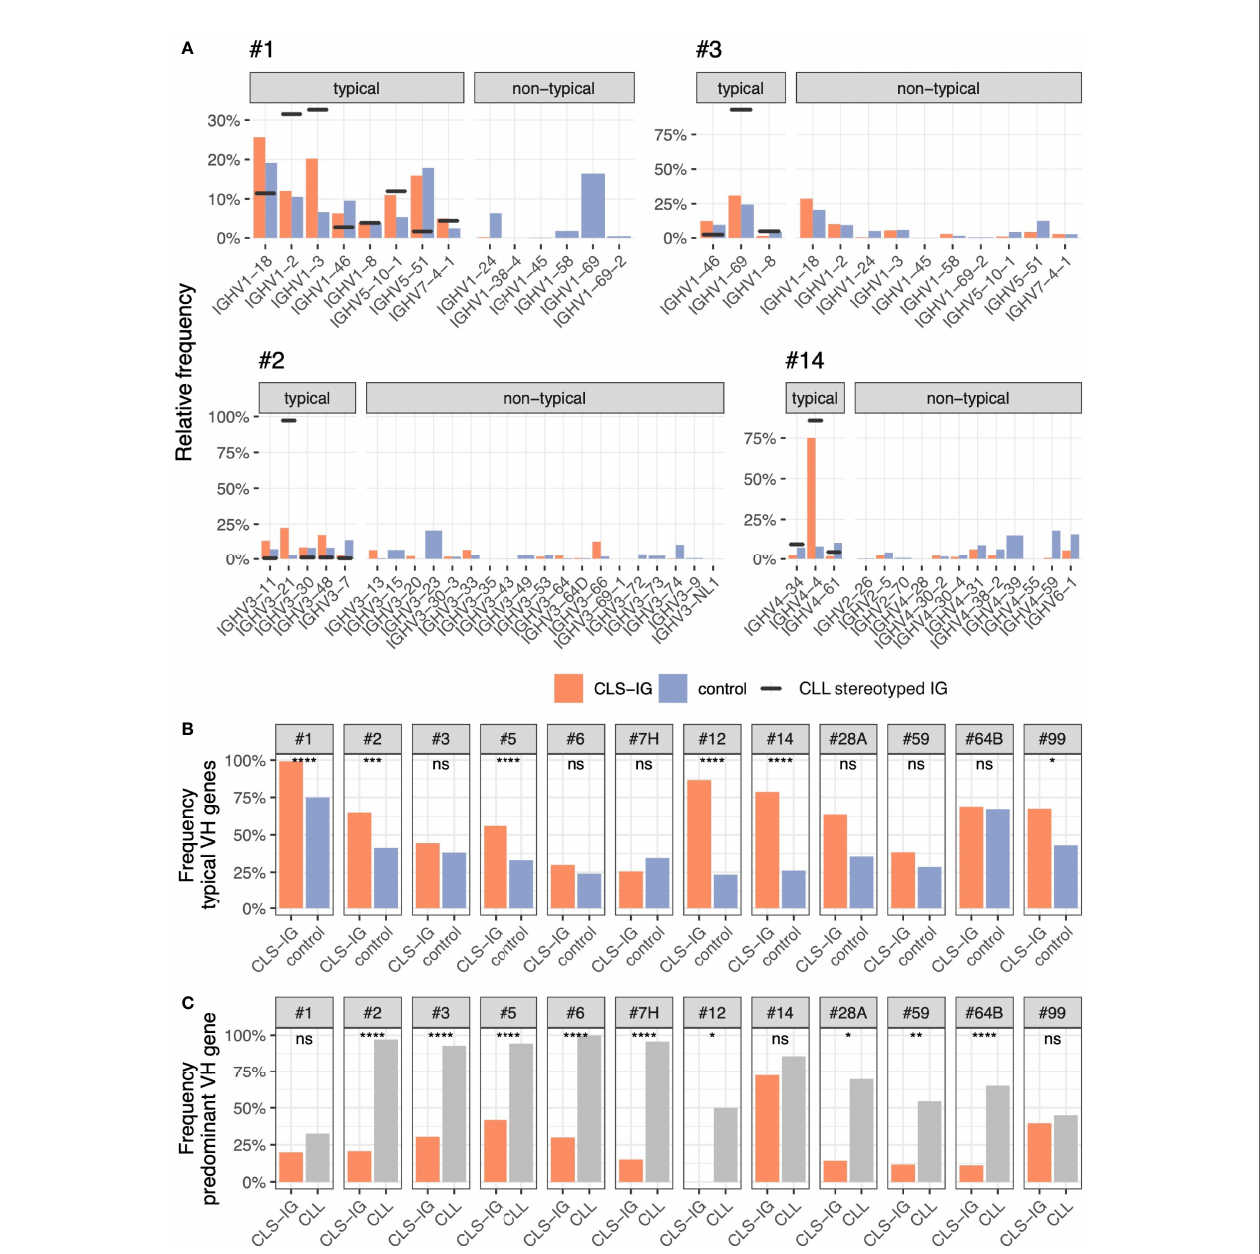
FIGURE 7 | (A) Frequency of IGHV gene used in typical and non-typical CLS-IG (red). Blue bars indicate non-CLS-IG control sequences (i.e., sharing the same core features as the CLL subset in consideration - IGHV clan, IGHV mutational status, and VH CDR3 length). These rearrangements were used as controls. Black horizontal lines indicate the level of IGHV representation in the reference CLL cohort. The predominant IGHV gene was identi fi ed as the most represented within a CLL subset. (B) Frequency of typical IGHV genes in CLS-IG clonotypes compared to control sequences. The control sequences are the same reported in panel (A) (C) Frequency of the predominant IGHV gene observed in CLL stereotyped IGs compared to CLS-IGs usage of the same IGHV gene. Binomial test was performed, only signi fi cant statistics are shown (*p ≤ 0.05, **p ≤ 0.01, ***p ≤ 0.001, ****p ≤ 0.0001; ns, not signi fi